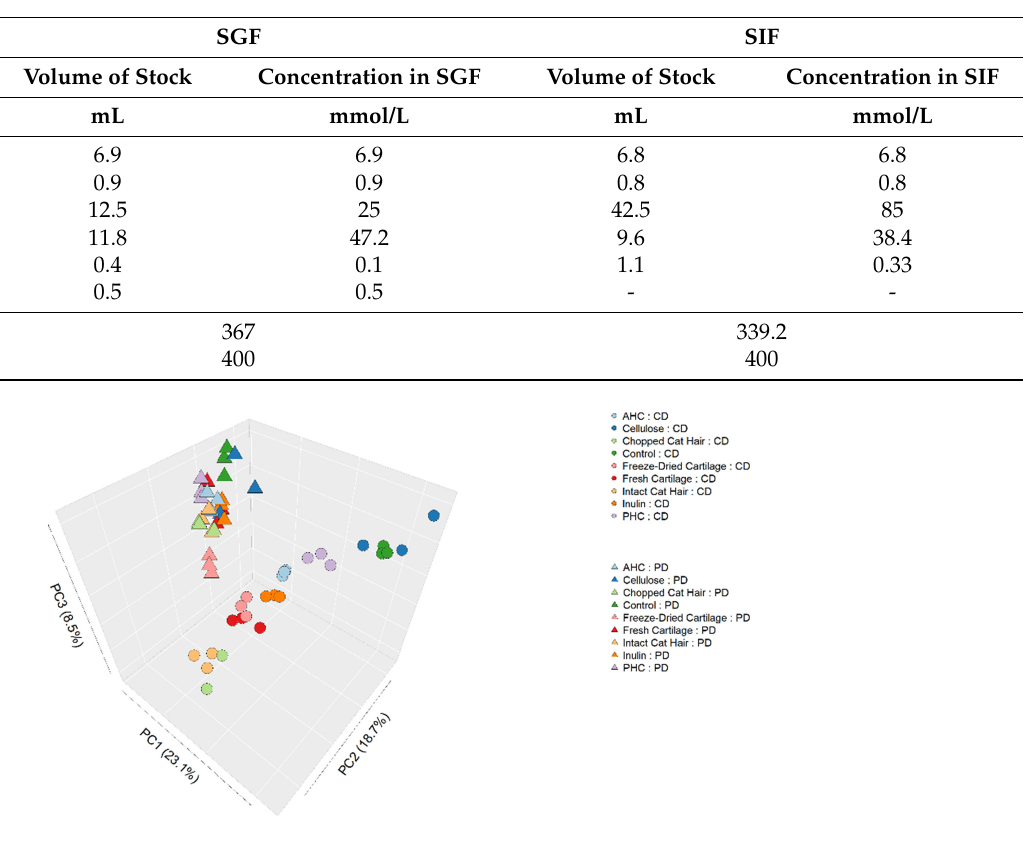
Figure A1. Principal components analysis of genera present in samples following in vitro fermenta- tion of each substrate at the 24-h time point in either high protein (PD) or high carbohydrate (CD) faecal inoculum. AHC; ANZCO hydrolysed collagen. PHC; Peptan hydrolysed collagen.